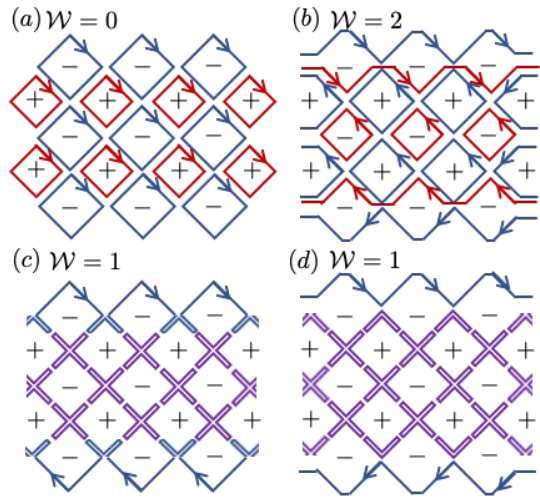
Figure 8: Phases of the coupled network model. States in network 1 are illustrated in blue and states in network 2 are illustrated in red. The edge states are easy to = 0 (no inter-layer coupling, see (a) determine in the limit J ε = 0, J δ = ± 1 and J p = 4 (maximum inter-layer coupling, (c) and (b)), as well as J ε = 0, J δ = ± 1 and J p and (d)). Going from (a) to (c) or (b) to (d) corresponds to turning on the inter-layer coupling J at the midpoints of the links, which connects the red and blue trajectories. p The purple lines indicate trajectories where states hop between the two networks in tight loops. The winding numbers corresponding to the different phases are indicated in the